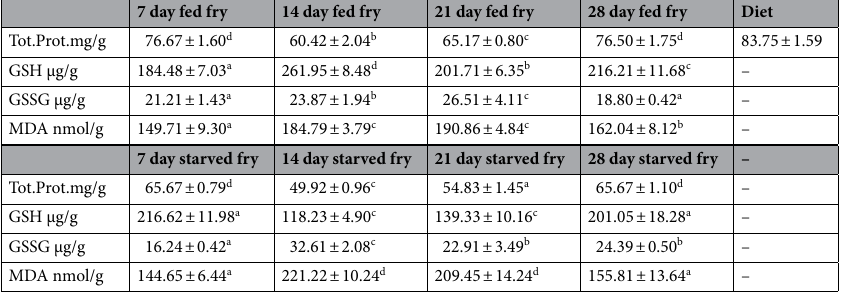
Table 3. Changes in Total Protein (Tot.Prot.), GSH, GSSG and MDA levels in fed and starved fry of Oncorhynchus mykiss .* * The meaning of the symbols is given under Table